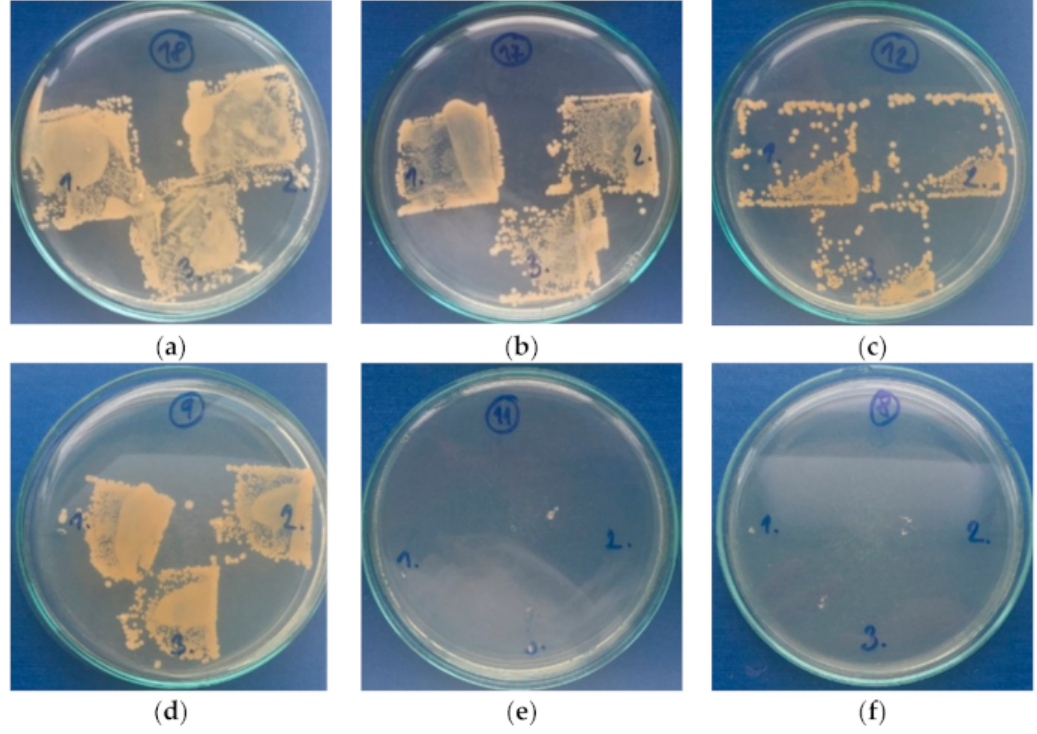
Figure 10. Total microbial counts on plate-count agar with inoculated Staphylococcus Aureus : ( a ) PE, ( b ) PU, ( c ) PDMS/PA-PE, ( d ) PDMS/PA-PU, ( e ) PDMS/PA/BSO-PE, ( f )